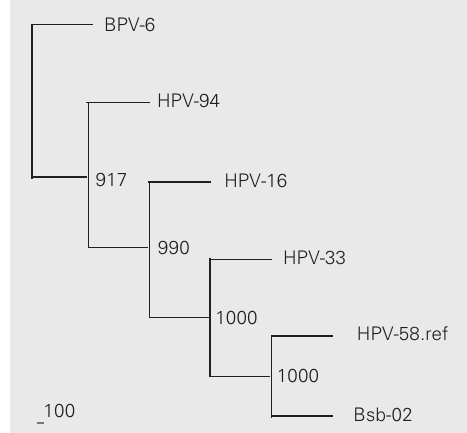
Figure 2. Phylogenetic neighbor- joining tree of L1 HPV se- quences, including that of the Bsb-02 isolate. The tree was rooted with the BPV-6 L1 se- quence. The numbers given at the branch points correspond to 1,000 bootstrap